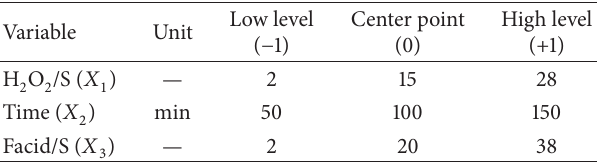
Table 1: Effect of aqueous phase acidity. Oxidative system Sulfur removal (%)